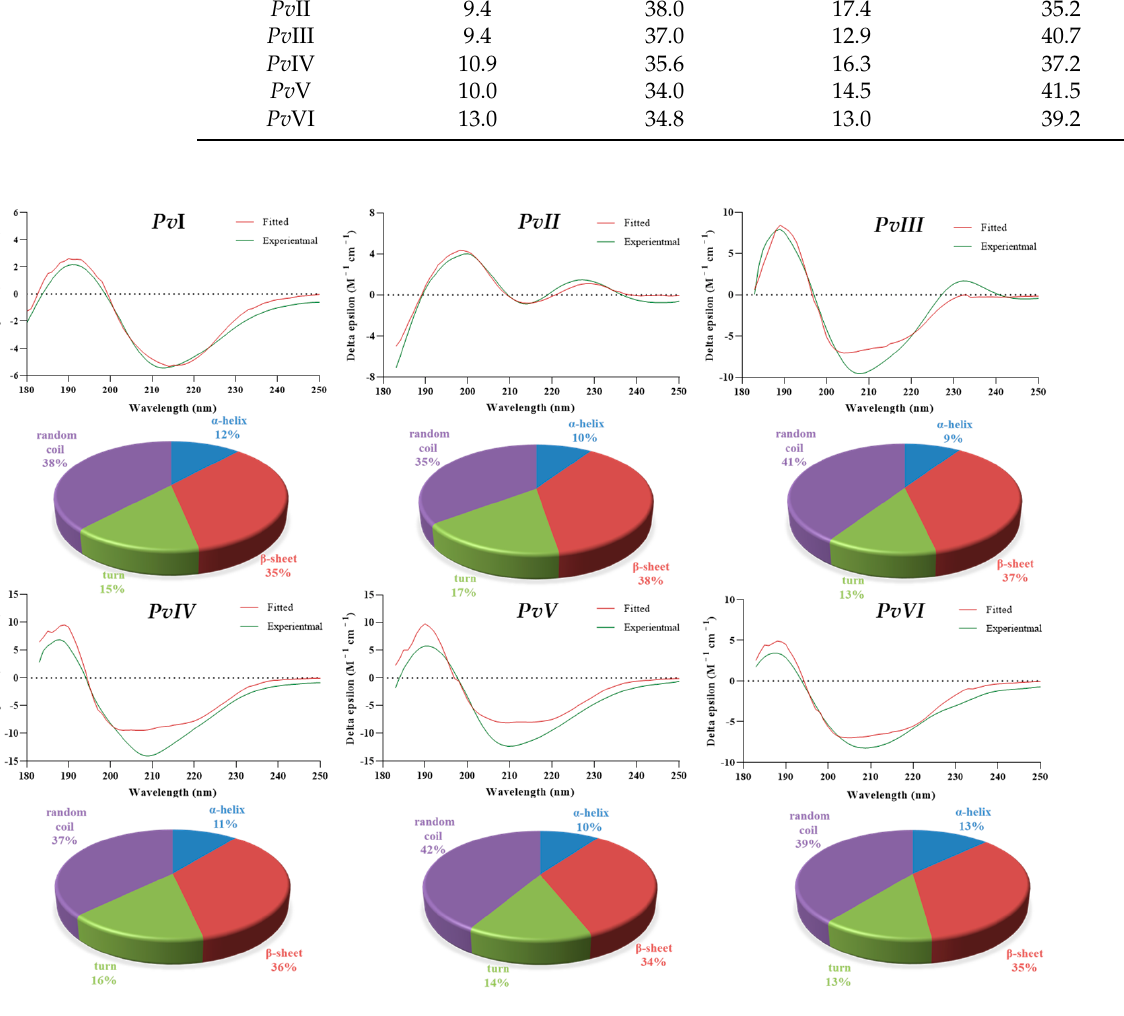
Figure 9. Modelled CD spectra of purified by BeSTSel online tool. The spectra comprise experimental values (green color) and reconstituted values (red color) and the pie charts represent different forms of secondary structure in purified proteases.